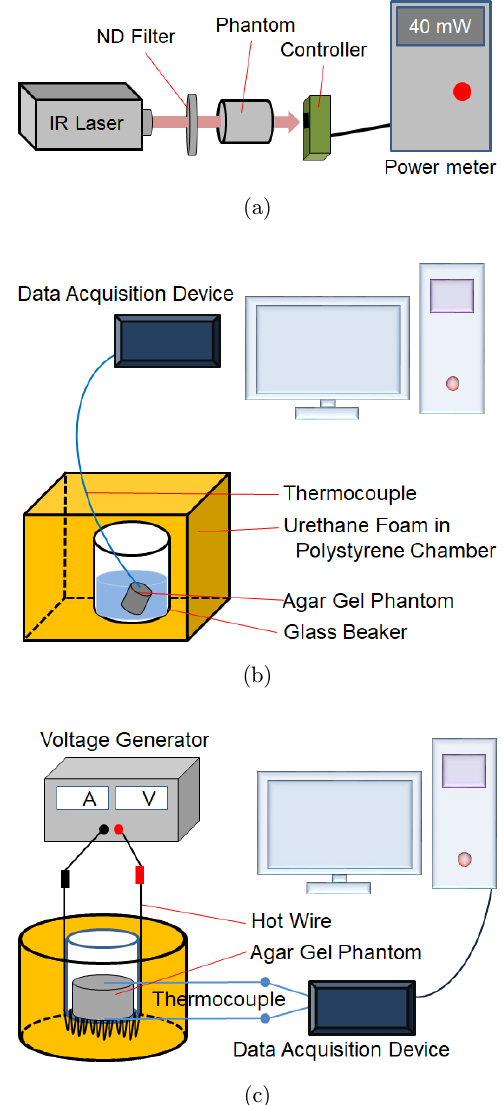
Fig. 1. Schematic of the measurement systems for (a) atten- uation coe±cient, (b) speci¯c heat and (c) thermal conductivity of tissue phantom made of agar gel.